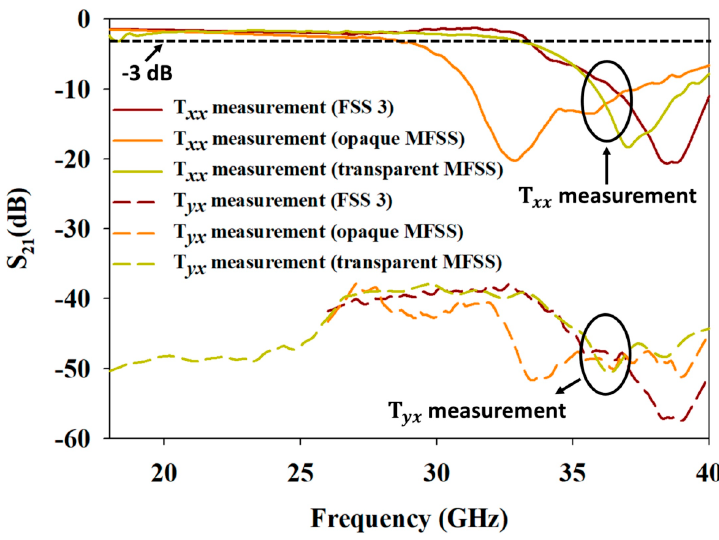
Figure 16. Experimental T (cid:3052)(cid:3051) of FSS 3, opaque MFSS, and transparent MFSS. To date, the investigation of FSS with low T (cid:3052)(cid:3051) has been rarely documented,